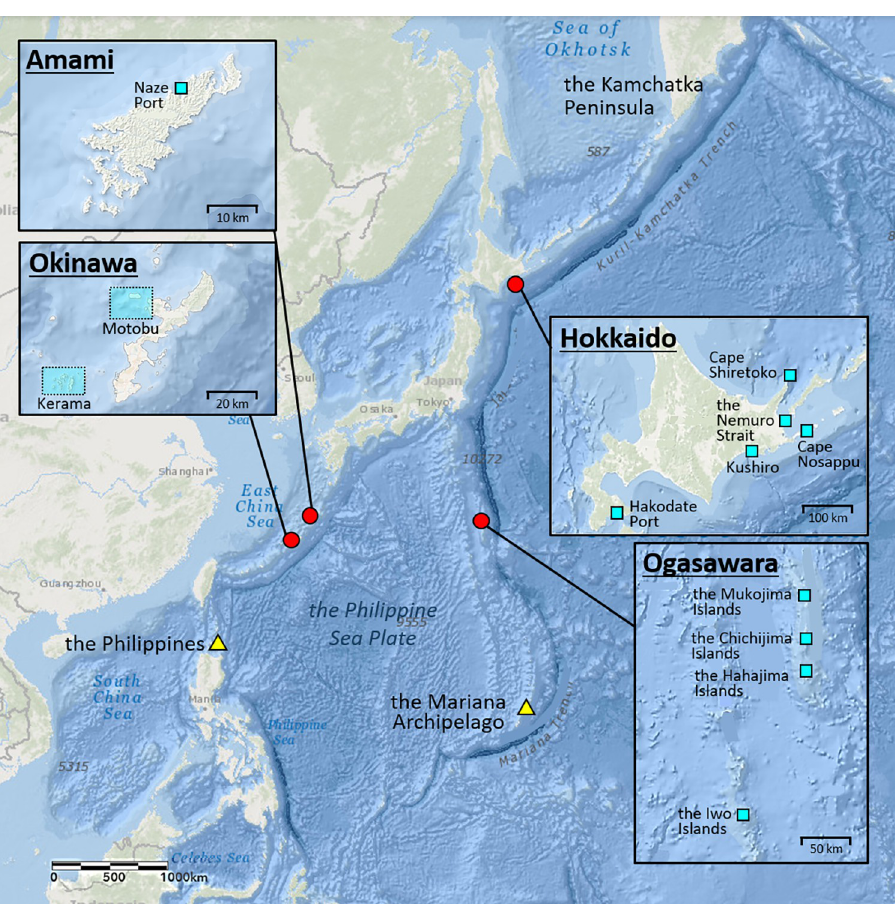
Fig 1. Locations of humpback whale survey areas in the western North Pacific. The blue squares in the enlarged maps represent the survey areas and/or departure ports of the survey vessels in each area in Japanese waters: Hokkaido, Ogasawara, Amami and Okinawa. The map image is published from PLOS ONE under a CC BY license, with permission from Environmental Systems Research Institute, Inc. (Esri), original copyright 2022, also the content is the intellectual property of Esri and is used herein with permission. Copyright © 2022 Esri and its licensors. All rights